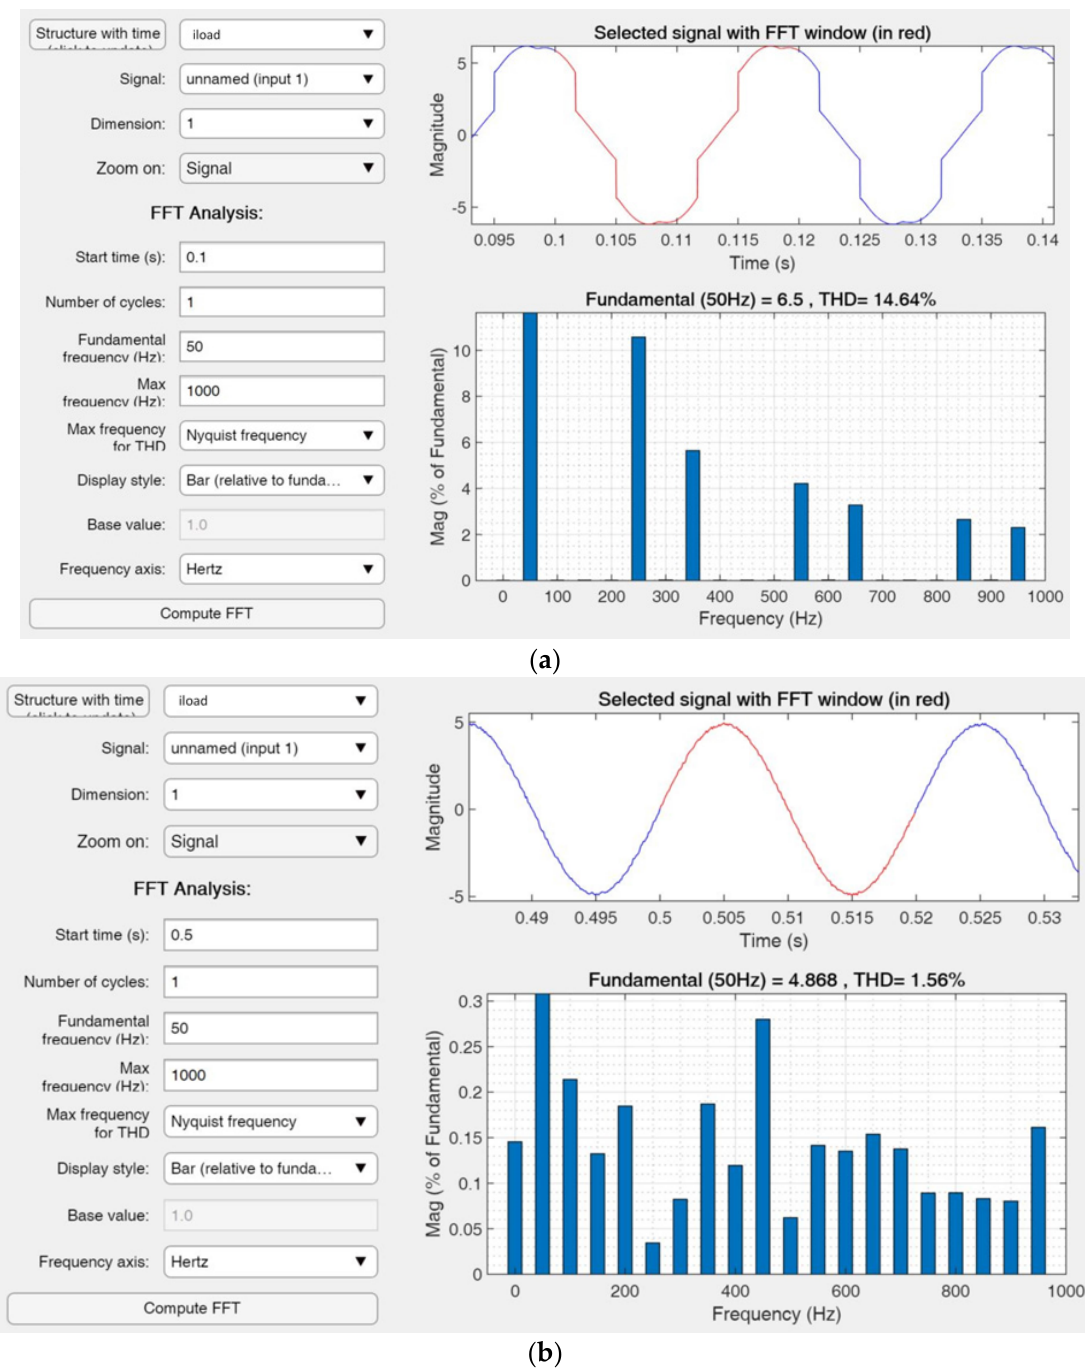
Figure 9. ( a ) Load current before the CVF filter; ( b ) load current after the CVF filter.